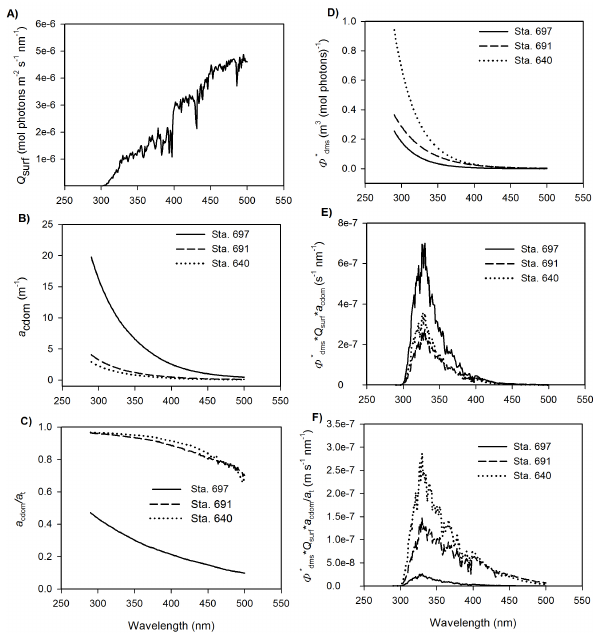
Fig. 3. Surface solar irradiance spectrum ( a , see definition in Sect. 3.2), examples of CDOM absorption spectra (b) and their cor- responding CDOM to total absorption ratios (c) , DMS photolysis AQY spectra (d) , and surface and water-column DMS photolyis ac- tion spectra (e, f)